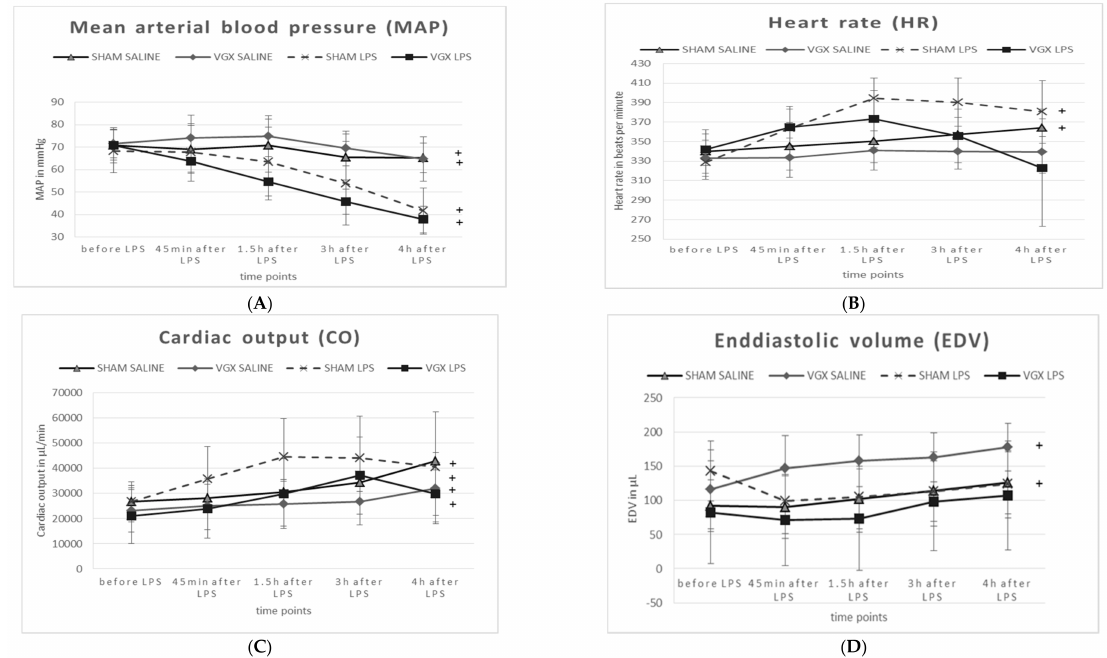
Figure 6. Effect over the experimental time in cardiovascular and hemodynamic measurements (( A ) mean arterial blood pressure, ( B ) heart rate, ( C ) cardiac output, ( D ) enddiastolic volume, mean ± SD) in control and endotoxemic rats and after right cardiac vagus nerve resection (VGX). Data are represented as means ± SD. Changes during the experimental period are presented: (end of the experiment versus data before LPS): “+”: time effect p ≤